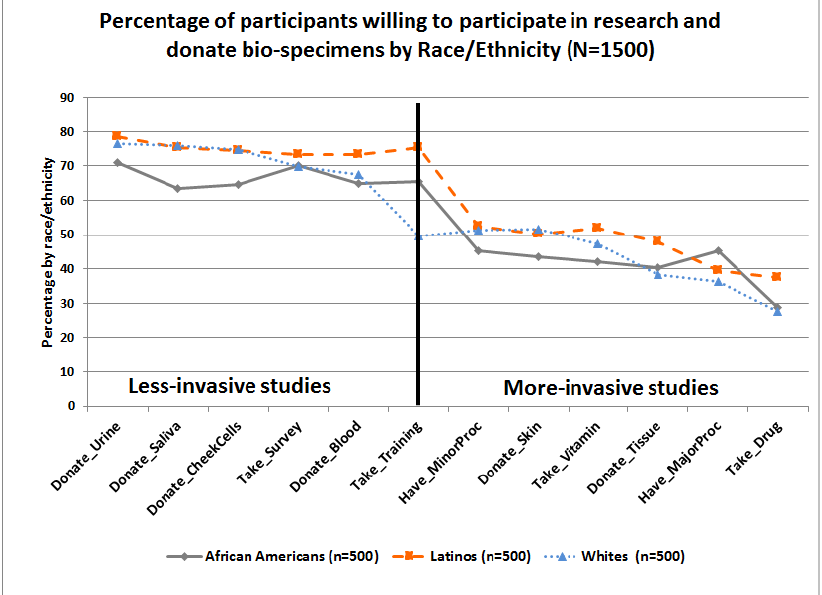
Figure 5. Item-level differences on willingness to participate in research and donate bio-specimens scale by race/ethnicity.